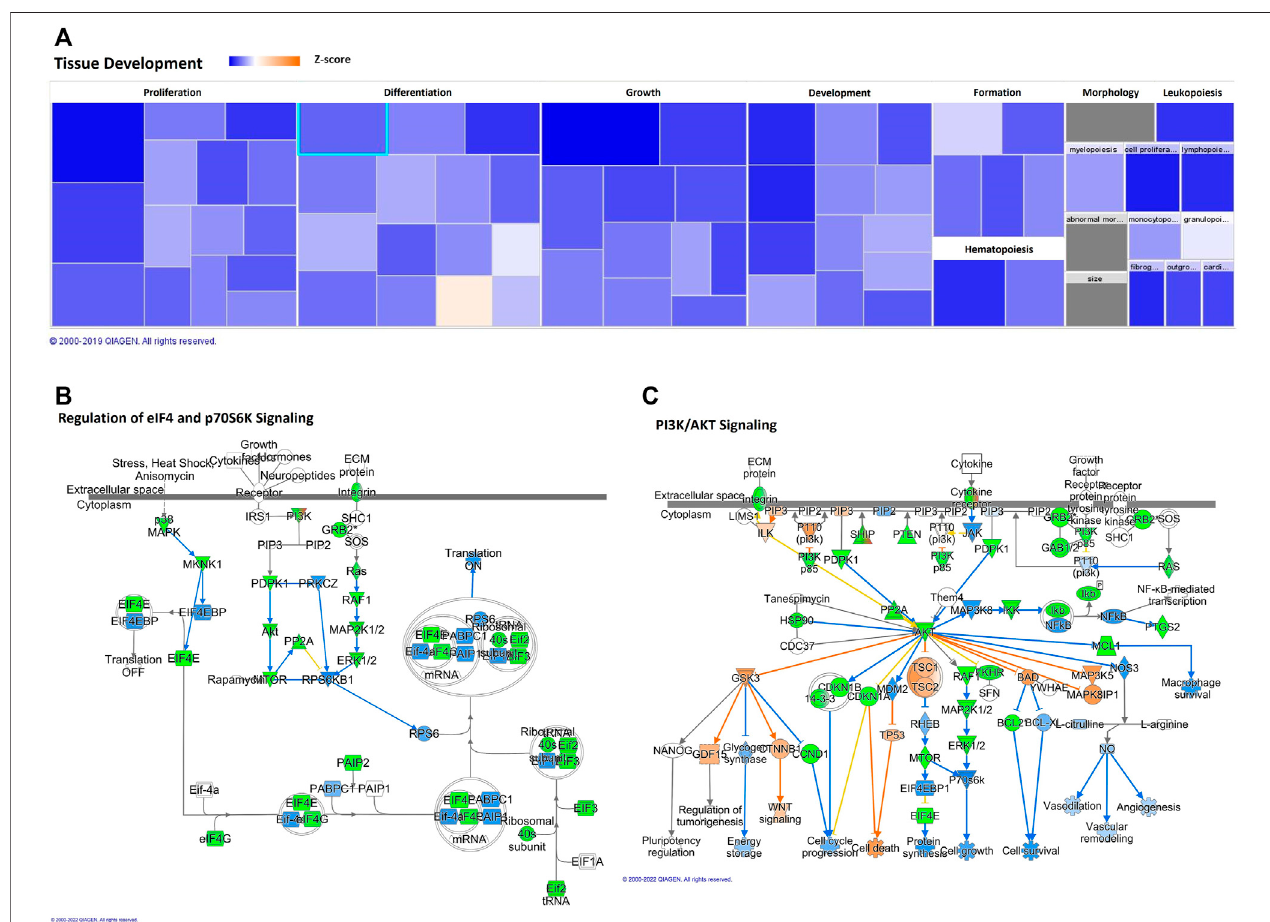
FIGURE 3 | Aging-induced predicted effects of miRNAs content in circulating adipocyte-derived EVPs on Tissue Development. (A) Heat map of the “ Tissue Development, ” among the top “ molecular and cellular functions ” categories. Each box represents one molecular and cellular function, its size represents gene enrichment. The heatmap is according to z-score values, where the color indicates the predicted increase or decrease status; higher z-scores would be represented by orangeindicatingactivation,andlowerz-scoreswasrepresentedbyblueindicatinginhibition. (B) Translationalcontrolcanonicalpathways,regulationofeukaryotic translation initiation factor 4 (eIF4) and p70S6K Signaling; mRNA Targets of microRNAs impacted by aging in circulating adipocyte-derived EVPs. Green color indicates predicted negative effect on mRNA targets, EIF3I (miR-24-3p), EIF4E (miR-15b-5p), EIF4G2 (miR-92b-3p), EIF4G2 (miR-210-5p and miR-377-5p), MAP2K1 and MAPK3(miR-15b-5p). (C) Phosphoinositide-3-kinase(PI3K)/AKTSignaling Canonical Pathwayimpactingprotein synthesis,proliferation, and survival.miR-92b-3pand miR-15b-5p target PIK3R3 and AKT3, respectively, and miR-503-3p targets the mammalian target of rapamycin